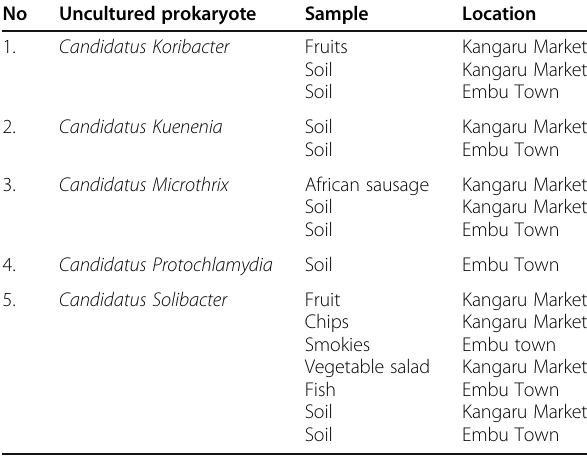
Table 3 Uncultured prokaryotes detected in vended foods and environmental samples from Embu Town and Kangaru